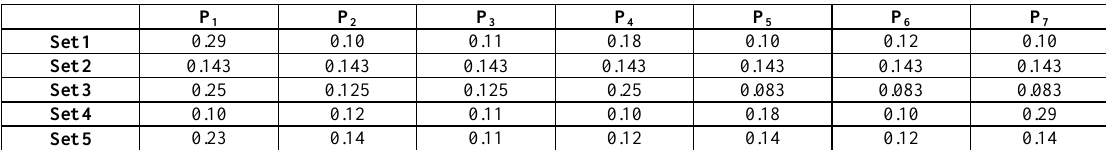
Table 5. Criteria weights in sensitivity analysis.